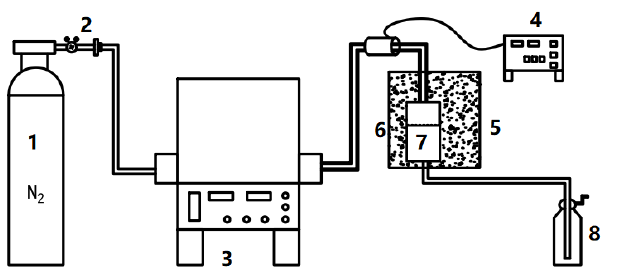
Figure 1. Sludge pyrolysis and PM collection device. 1: Nitrogen, 2: Rotor flow, 3: Tube furnace, 4: Heating tube, 5: Sand bath, 6: PM sampler, 7: Quartz filter, 8: Wash gas